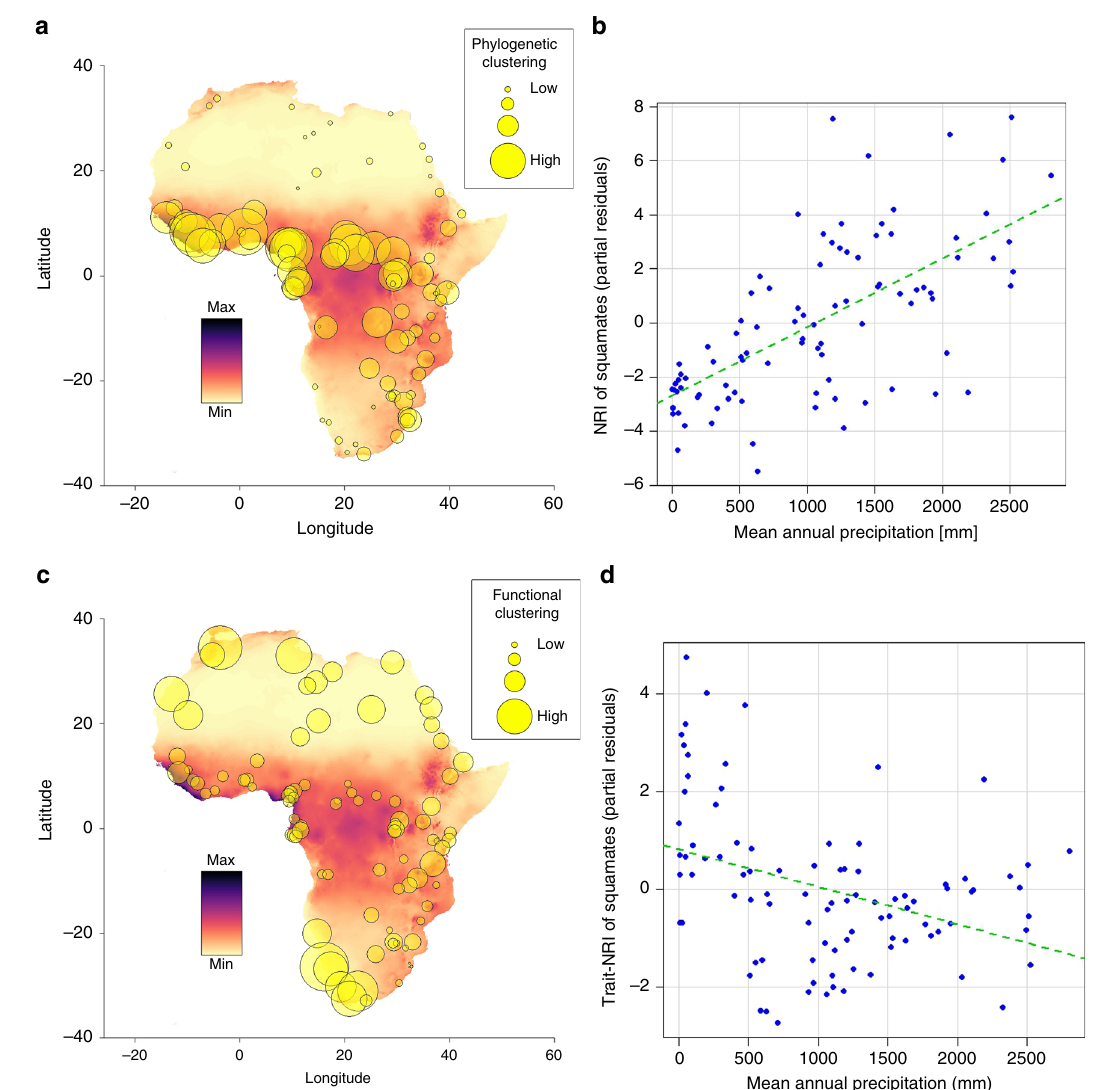
Fig. 4 Spatial distribution of phylogenetic and functional structure. a , c Spatial distribution of phylogenetic and functional structure of African squamates, showing correlations with mean annual precipitation (most important variable according to AICc weights). The colour gradient represents a gradient of mean annual precipitation from high (dark) to low (light). b , d Partial residual plots of phylogenetic and functional structure and mean annual precipitation of the best respective ordinary least